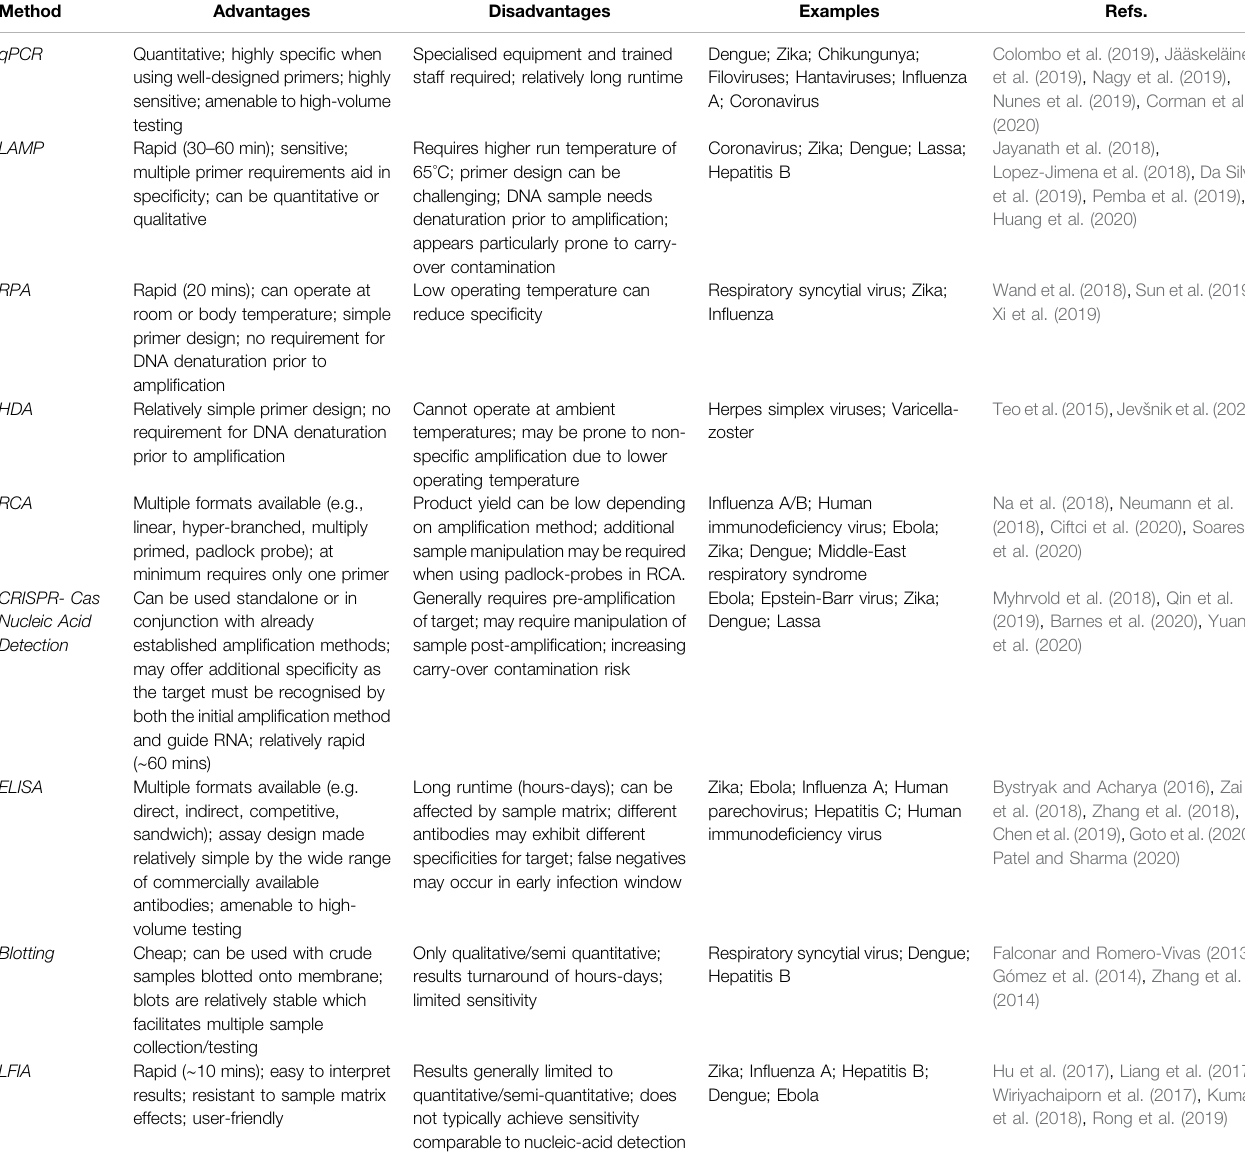
TABLE 1 | Summary of the advantages, disadvantages and example applications off nucleic acid-based and immunoassay-based approaches to virus detection.